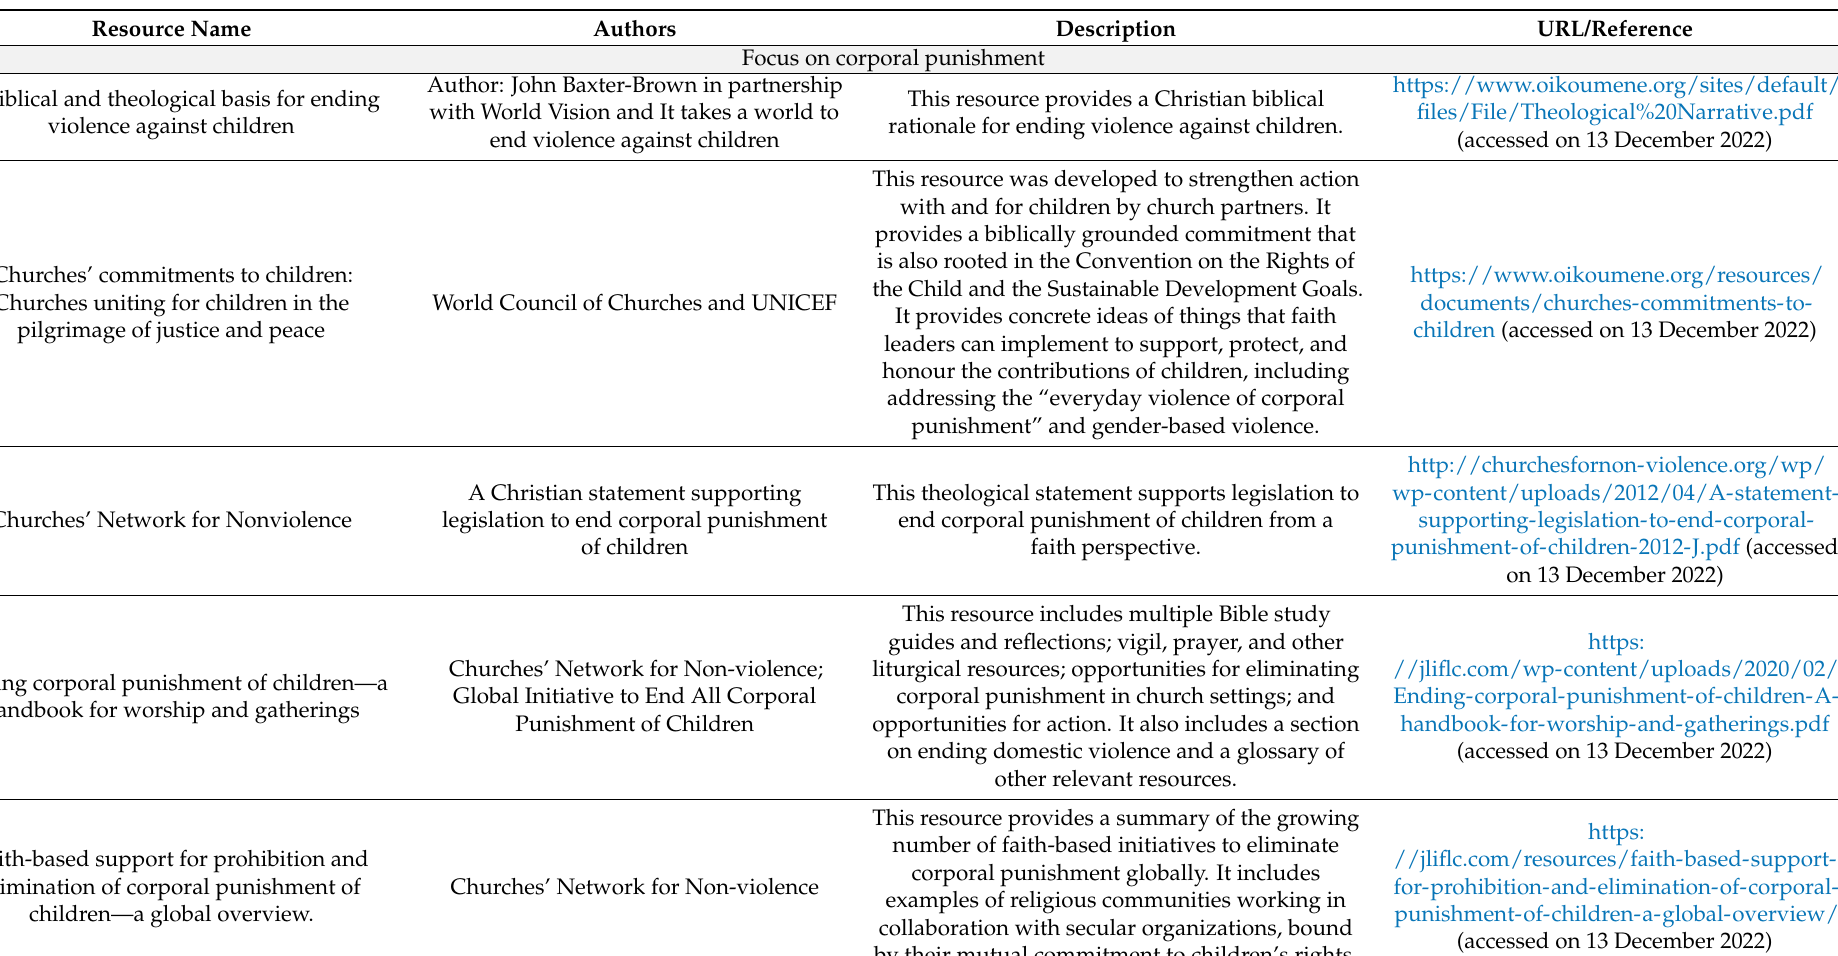
Table 1. Faith-based resources for addressing corporal punishment and gender-based